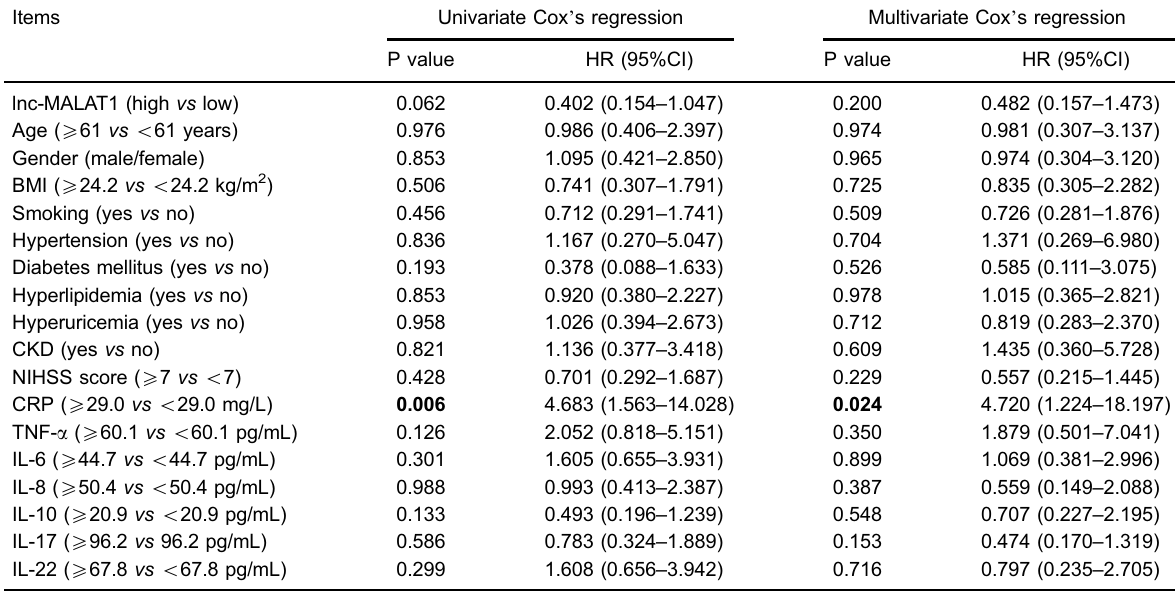
Table 3. Factors affecting recurrence-free survival by Cox ’ s proportional hazards regression model analyses.